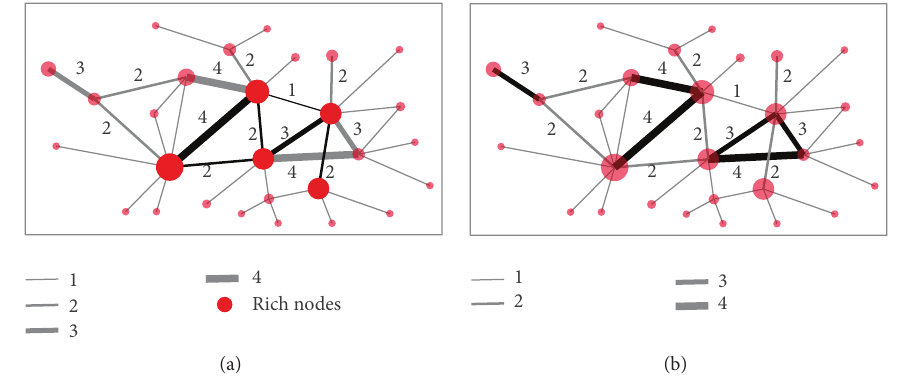
Figure 6: Schematic representation of a weighted network